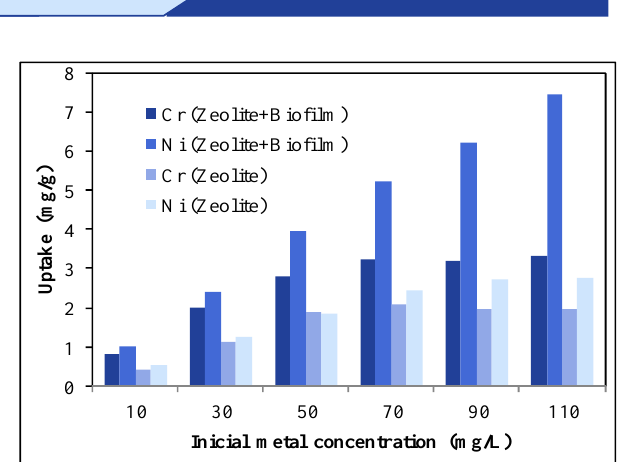
Figure 2. Effect of initial metal concentration on 2 shows the effect of initial uptake values of nickel and chromium resistance between the liquid phase and solid phase. Thus, it is expected that with an increase in metal ions the metal uptake will increase.